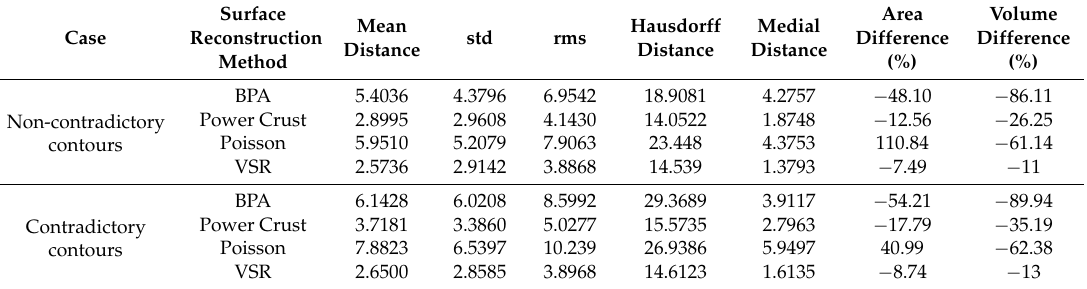
Figure 14. Surface reconstruction of contradictory contours of the kidney. ( a ) Contradictory contour: the original horizontal contour (yellow) should intersect with the vertical contour (blue), but the edited version of the horizontal contour (red) did not intersect with the vertical contour (blue); ( b ) surface reconstruction from the original contours; ( c ) surface reconstruction from the contradictory contours. For row b and c, from left to right: the original surface of the kidney, the surface reconstructed by BPA, the surface reconstructed by Power Crust, the surface reconstructed by Poisson, and the surface reconstructed by VSR. ( d ) Detail of the surface reconstruction near the intersection of the contradictory contours. From left to right: the original surface of the kidney and the contradictory contours, the surface reconstructed by BPA, the surface reconstructed by Power Crust, the surface reconstructed by Poisson, and the surface reconstructed by VSR. Table 5. Difference between the reconstructed surfaces from contradictory contours and the original surface (HUMAN KIDNEY).